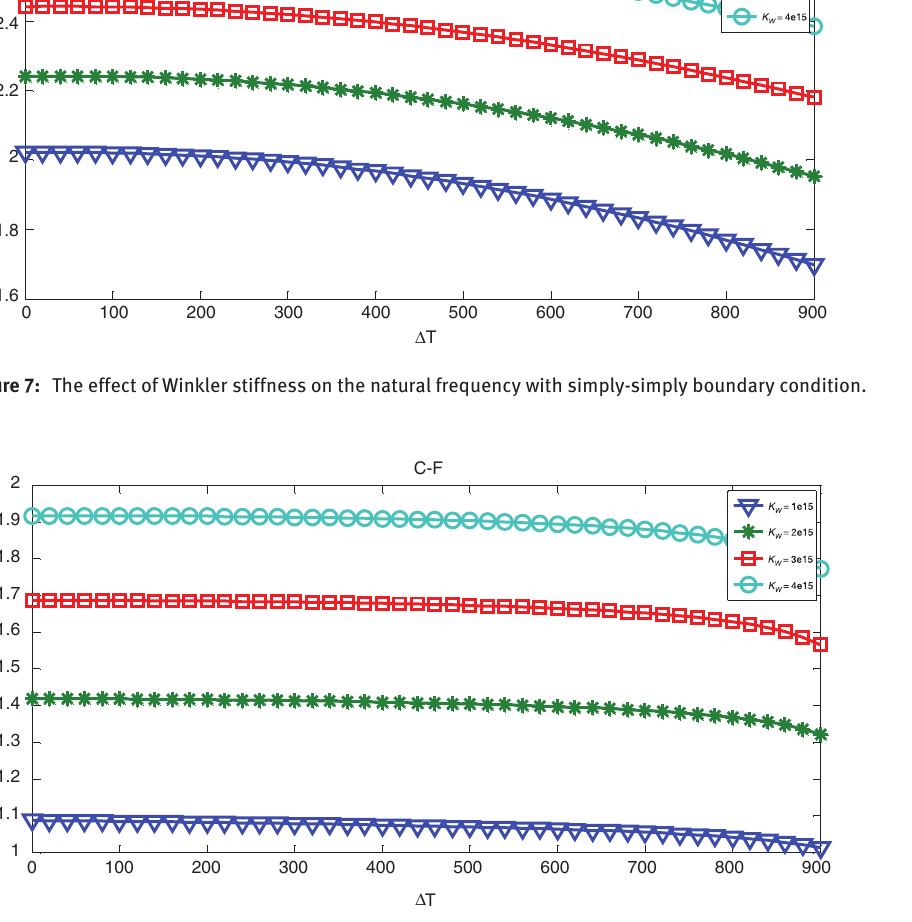
Figure 8: The effect of Winkler stiffness on the natural frequency with clamped-free boundary